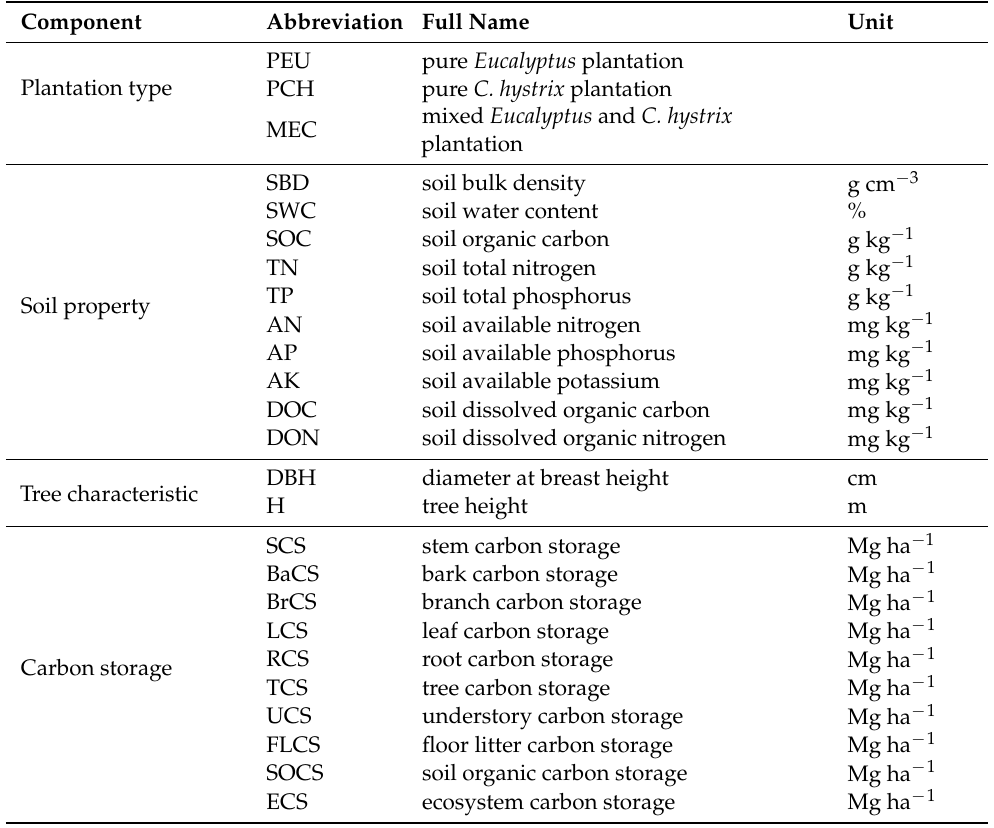
Figure 1. A schematic plot of study area and experimental design. PEU, PCH, and MEC indicate pure Eucalyptus plantation, pure C. hystrix plantation, and mixed Eucalyptus and C. hystrix plantation, respectively. Numbers following the abbreviations of the plantations indicate replications. Table 1. Abbreviations, full name and unit of plantation types, soil properties, soil microbial community, tree characteristics, and carbon storage.